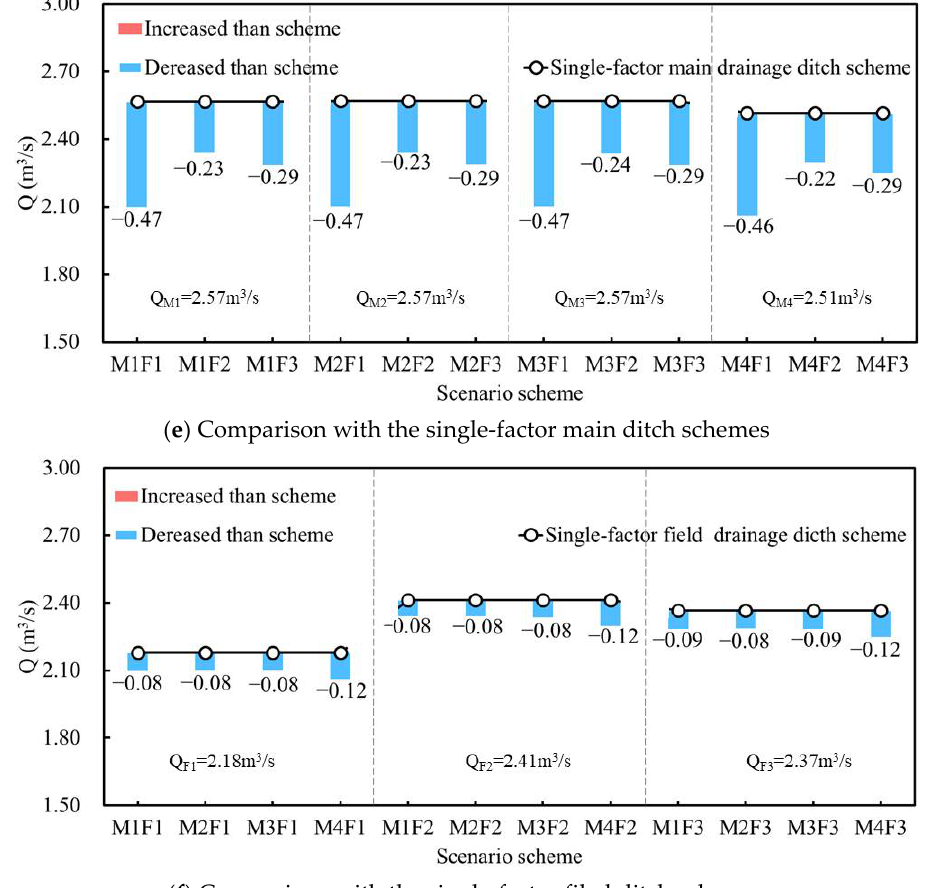
Figure 7. Comparison of crop yield and regional drainage discharge under the effect of combined control schemes. ( a , b ) Crop yield compared with the single-factor main ditch schemes; ( c , d ) the crop yield compared with the single-factor field schemes; ( e , f ) regional drainage discharge compared with the single-factor main ditch and filed ditch schemes. YM1–YM4: the crop yield under the single-factor main ditch schemes; YF1–YF3: the crop yield under the single-factor field ditch schemes; QM1–QM4: the Q under the single-factor main ditch schemes; QF1–QF3: the Q under the single-factor field ditch schemes.